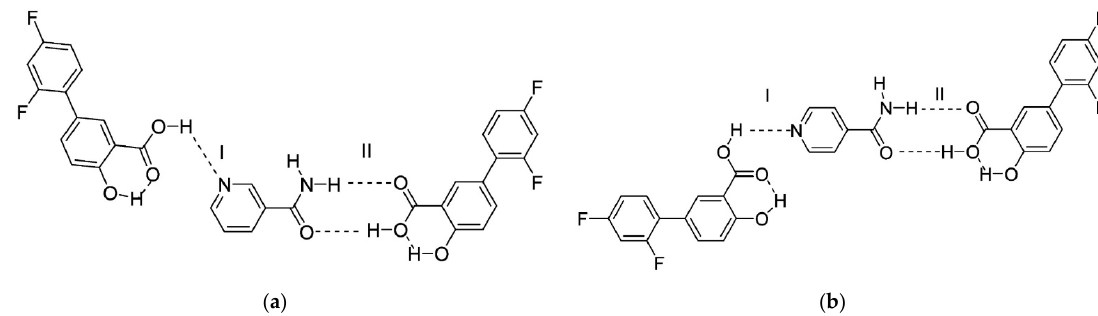
Figure 14. Structure of co-crystals formed between diflunisal and ( a ) nicotinamide, ( b ) isonicotinamide. Here, (I) represents the carboxylic acid–pyridine synthon; (II) represents the carboxylic acid–amide synthon. Reproduced from [58], with permission from American Chemical Society, 2021.